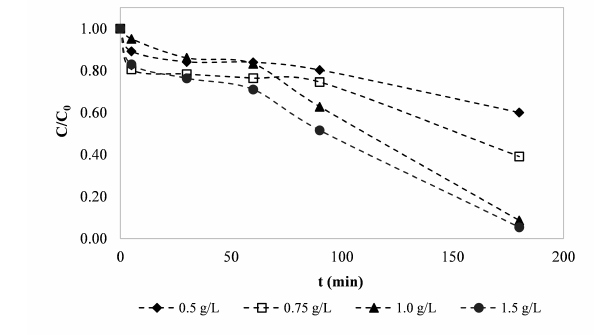
Fig. 3. Effect of catalyst dosage (MO=50 mg/L; H 2 O 2 =6.6 mM; pH=3; T=30 ◦